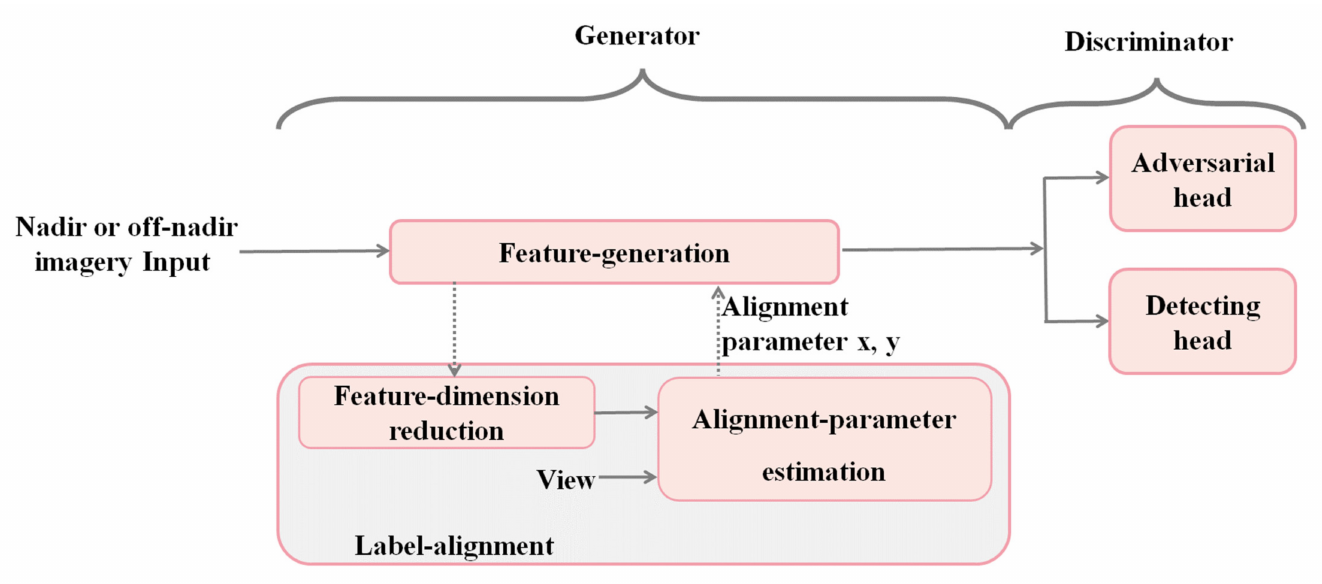
Figure 3. Overview of NaGAN. NaGAN consists of a generator and a discriminator. The generator aims to generate a nadir-like representation for the off-nadir object, which consists of the feature generation and the label alignment. The former is used to generate the nadir-like representation for the off-nadir object, while the latter helps the former align the off-nadir object to the label of the nadir object. The discriminator consists of two heads, the adversarial head and the detecting head. The adversarial head aims to discriminate the generated nadir-like representation of the off-nadir object from the real nadir object, and the detecting head aims to benefit the detection